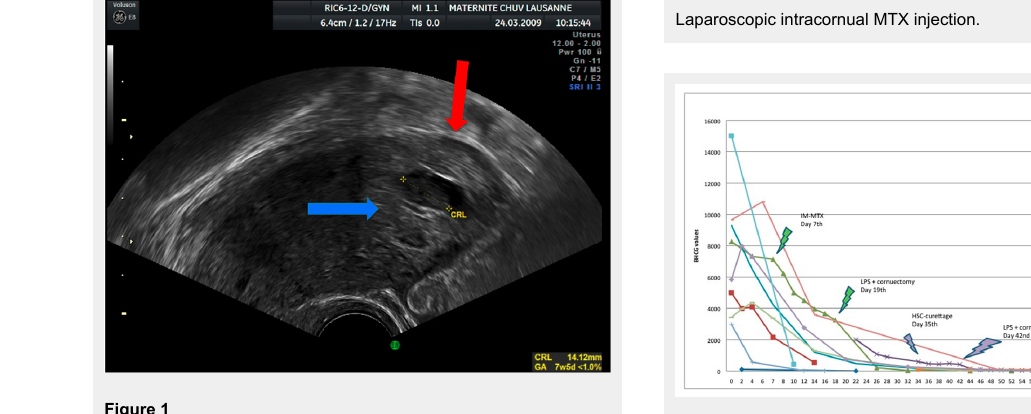
Figure 3 Beta-HCG level follow up after first, second and third line